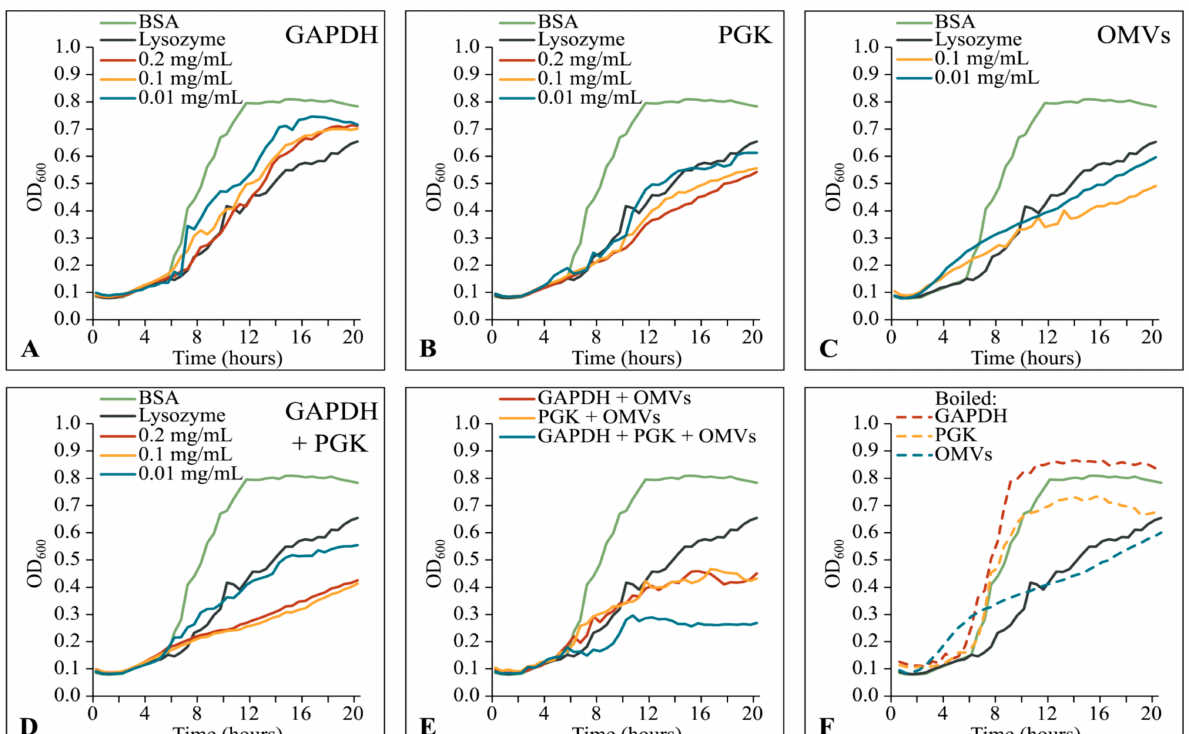
Figure 5. Lysis zones of GAPDH, PGK and OMVs on E. coli agar. Error bars reflect standard deviation ( n = 3). Numbers below bars provide the concentration of each added component in mg/mL. Lys denotes lysozyme (positive control).